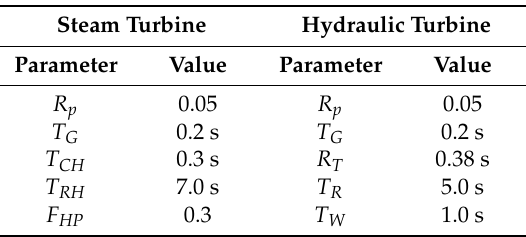
Table 4. Typical values of turbine parameters.